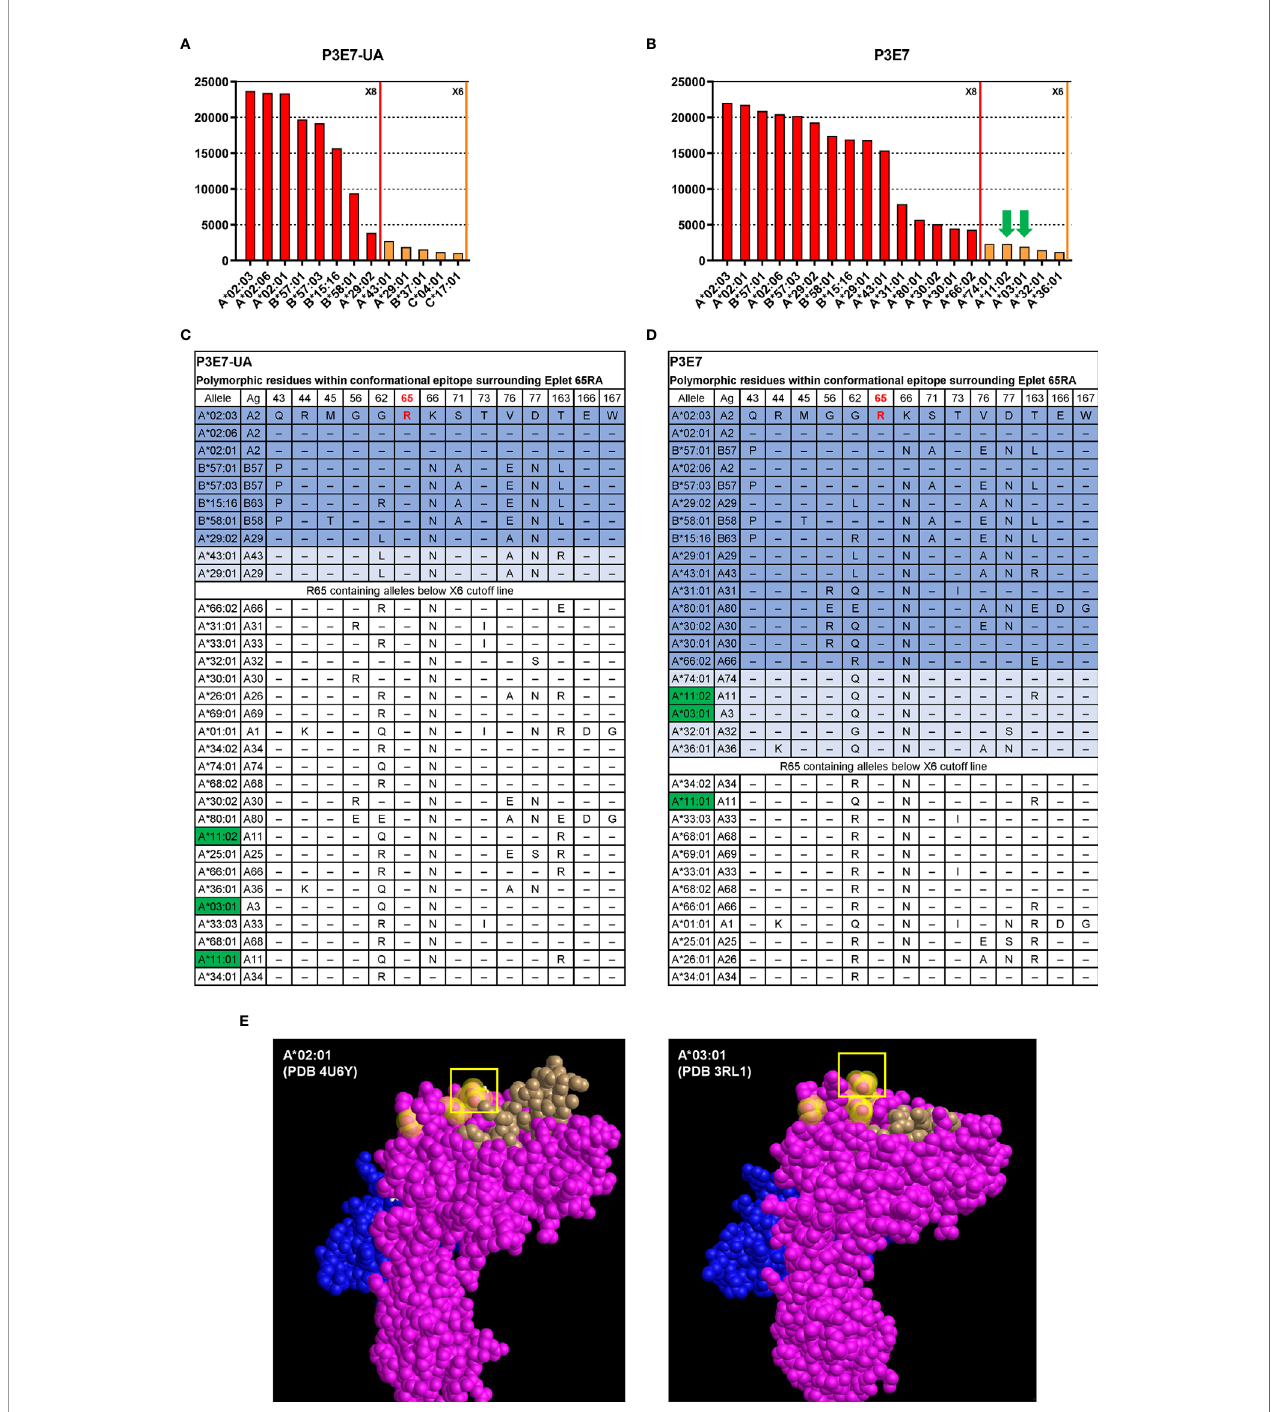
FIGURE 5 | Interrogation of HLA-A*02 speci fi c recombinant antibodies isolated from an allo-sensitized patient. HLA binding speci fi cities of rAbs P3E7-UA (A) and P3E7 (B) using a Luminex ® single HLA antigen bead 100-plex panel. Alleles with MFI values above the X6 threshold (MFI > 1000) are shown. Autologous alleles are indicated with green arrows. (C, D) HLA alleles sharing eplet 65RA and the polymorphic amino acids within this potential 15 Å conformational epitope. Alleles are listed in the order of MFI values from high to low. Alleles above the X8 threshold (MFI > 3000) are shaded in dark blue and alleles above the X6 threshold in light blue. Autologous HLA alleles are highlighted in green. (E) Three-dimensional structure of allogeneic (A*02:01) and autologous HLA structures from published data with PDB ID indicated. HLA a chain (pink), b 2M (blue) and bound peptide (brown) are visualized using Cn3d software. Residues 56, 62, and arginine at position 65 (box) are highlighted